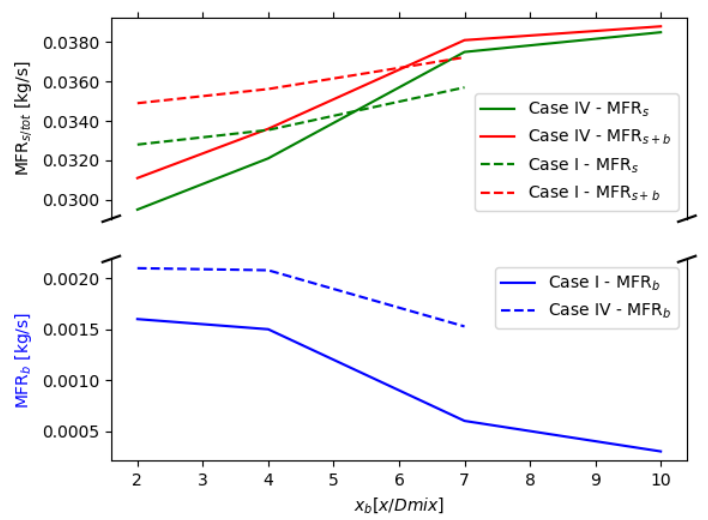
Figure 8. Plot of bypass (blue) and suction (green) mass flow rate as a function of bypass inlet position. The total pumped flow rate is shown in red.